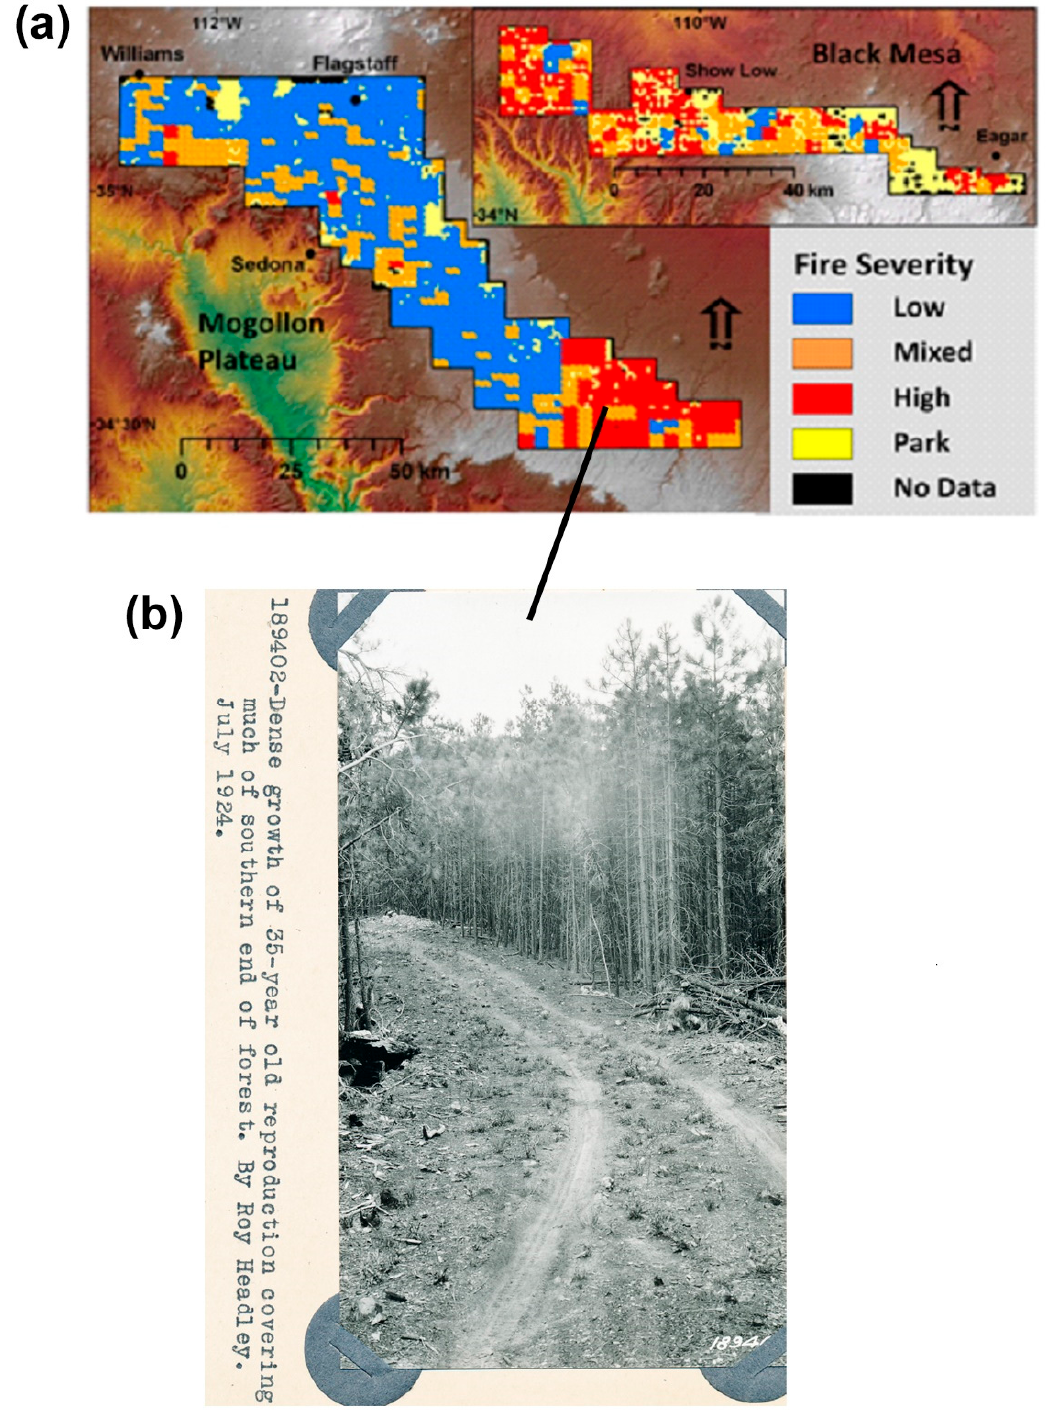
Figure 2. ( a ) “Fire severity evidence from forest structure, based on survey reconstructions on the Mogollon Plateau and nearby Black Mesa, Arizona.” Note the extensive mixed- to high-severity fire on Black Mesa compared to the more extensive low- to mixed-severity fire on the Mogollon Plateau. Reprinted from [24] with permission from John Wiley and Sons, and ( b ) a photograph taken in 1924 by Roy Headley, Historical Photo Collection, Region 3, U.S. Forest Service, Albuquerque, New Mexico.